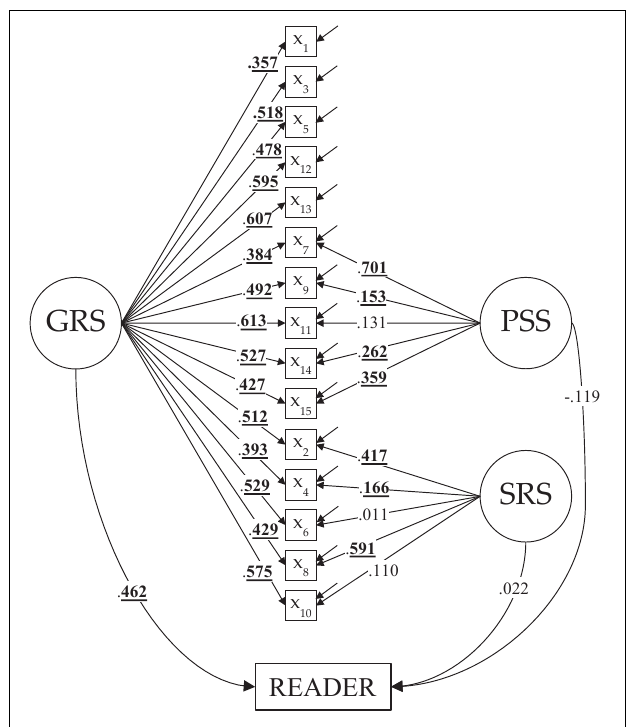
FIGURE 2 | Confirmatory factor analysis parameter estimates of the S-1(GRS) model by regressing READER variable onto latent factors (GRS, PSS, and